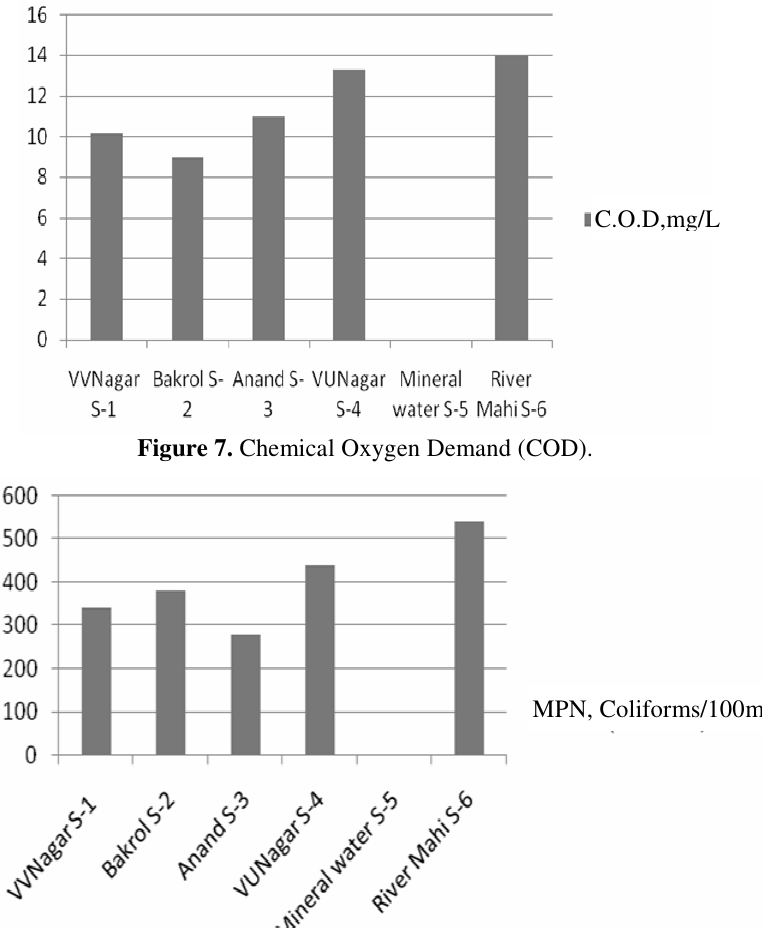
Figure 8. Bacterial Count